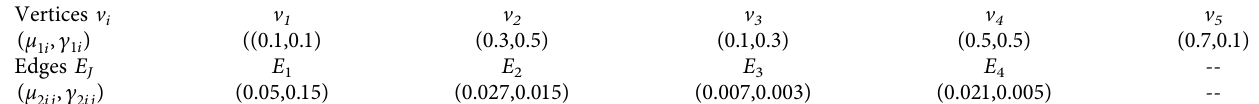
Table 10: The values for degree of membership and nonmembership of vertices and edges of Figure 10.